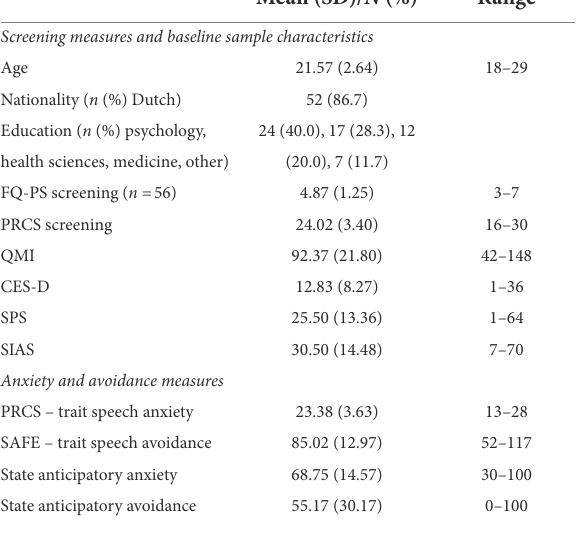
TABLE 1 Descriptives for screening measures, baseline sample characteristics, and anxiety and avoidance measures. Mean ( SD )/ N (%)